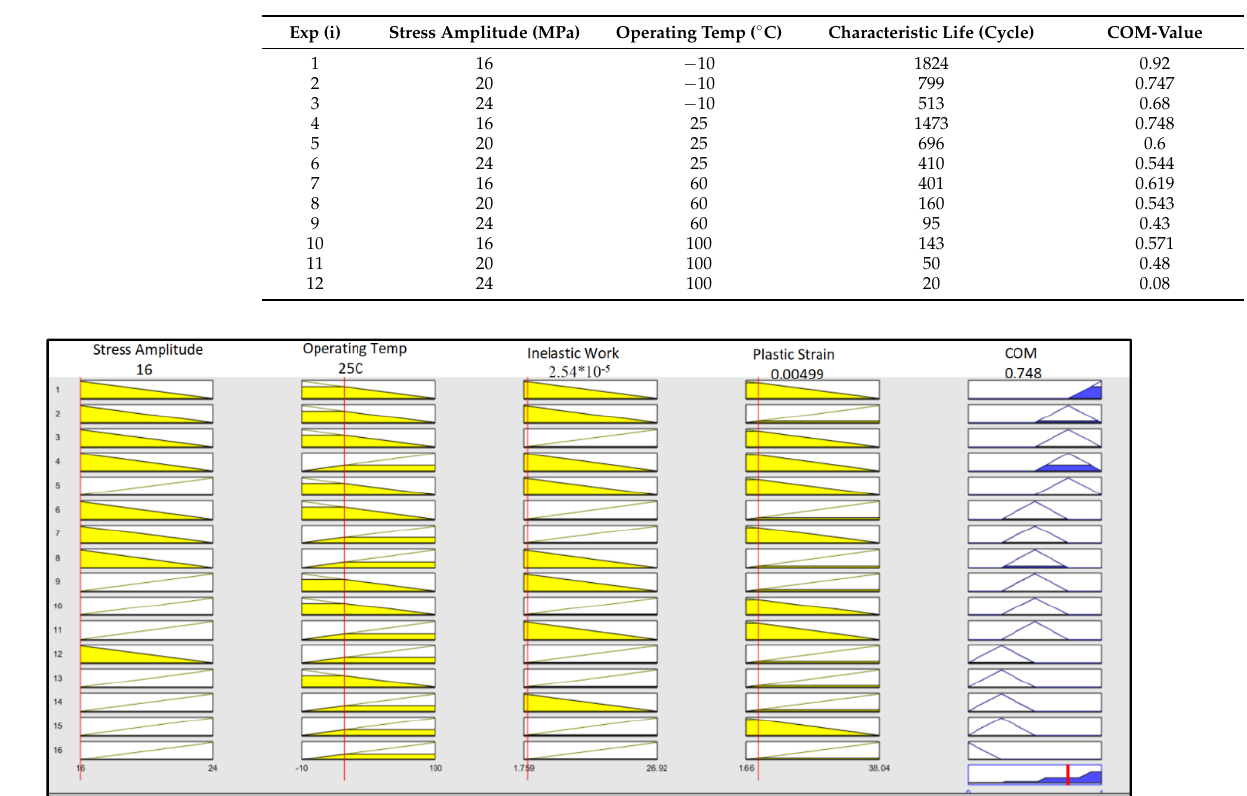
Figure 12. COM-Value from MATLAB software (the yellow color represents the area of the input MFs, the red lines for the actual input data, and the blue color for area of the output MFs). Table 5. COM-Value at each experimental combination with characteristic life values.